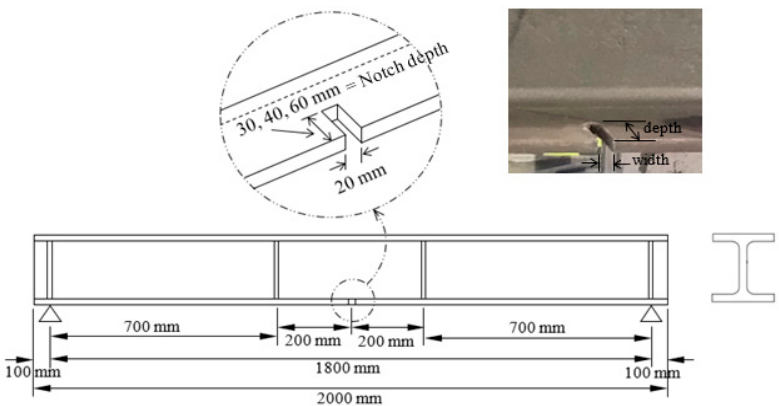
Figure 1. Dimensions of damaged beam specimens.